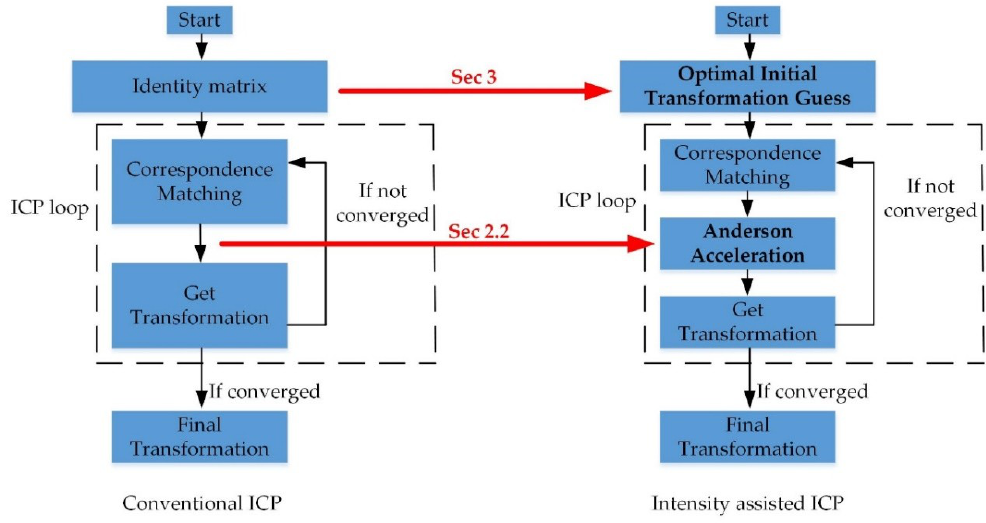
Figure 1. An overview of intensity-assisted iterative closest point (ICP) method compared with conventional ICP.